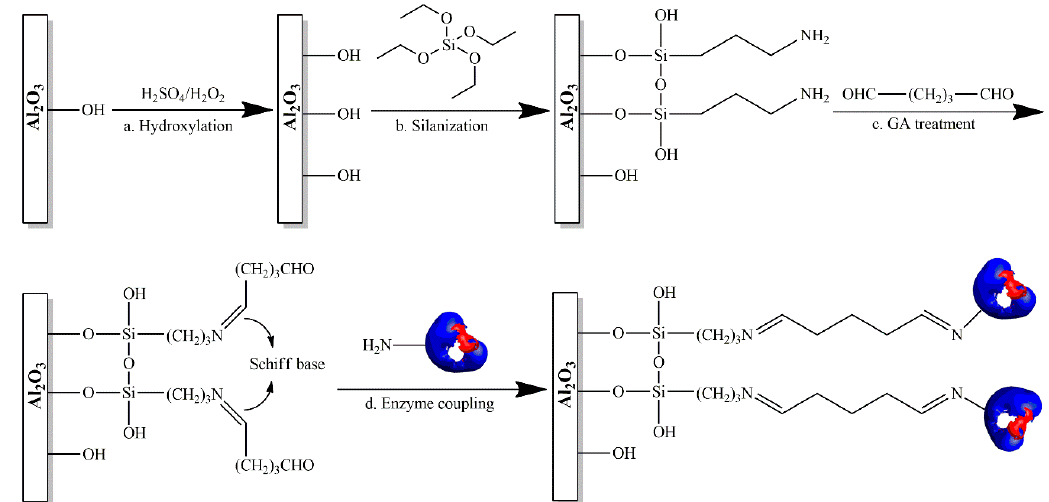
Figure 6. Stages involved during immobilization process: ( a ) Hydroxylation process by immersing inorganic hollow fiber membranes in a piranha solution; ( b ) Silanization process by treating membranes with APTES solution; ( c ) Cross-linker binding between glutaraldheyde and amino-group of silane by forming Schiff base; ( d ) Enzyme covalent binding on the inorganic hollow fiber membranes.